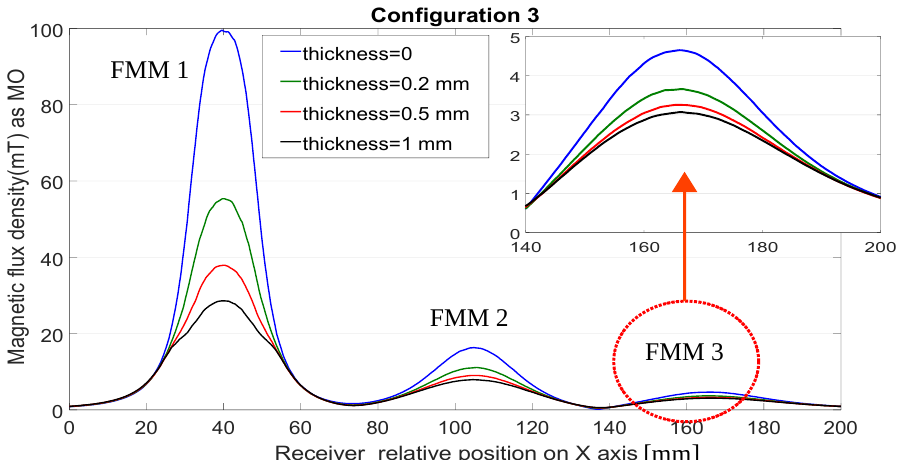
Figure 15. Configuration 3: output signal with reactive-part variations in the presence of rebar.